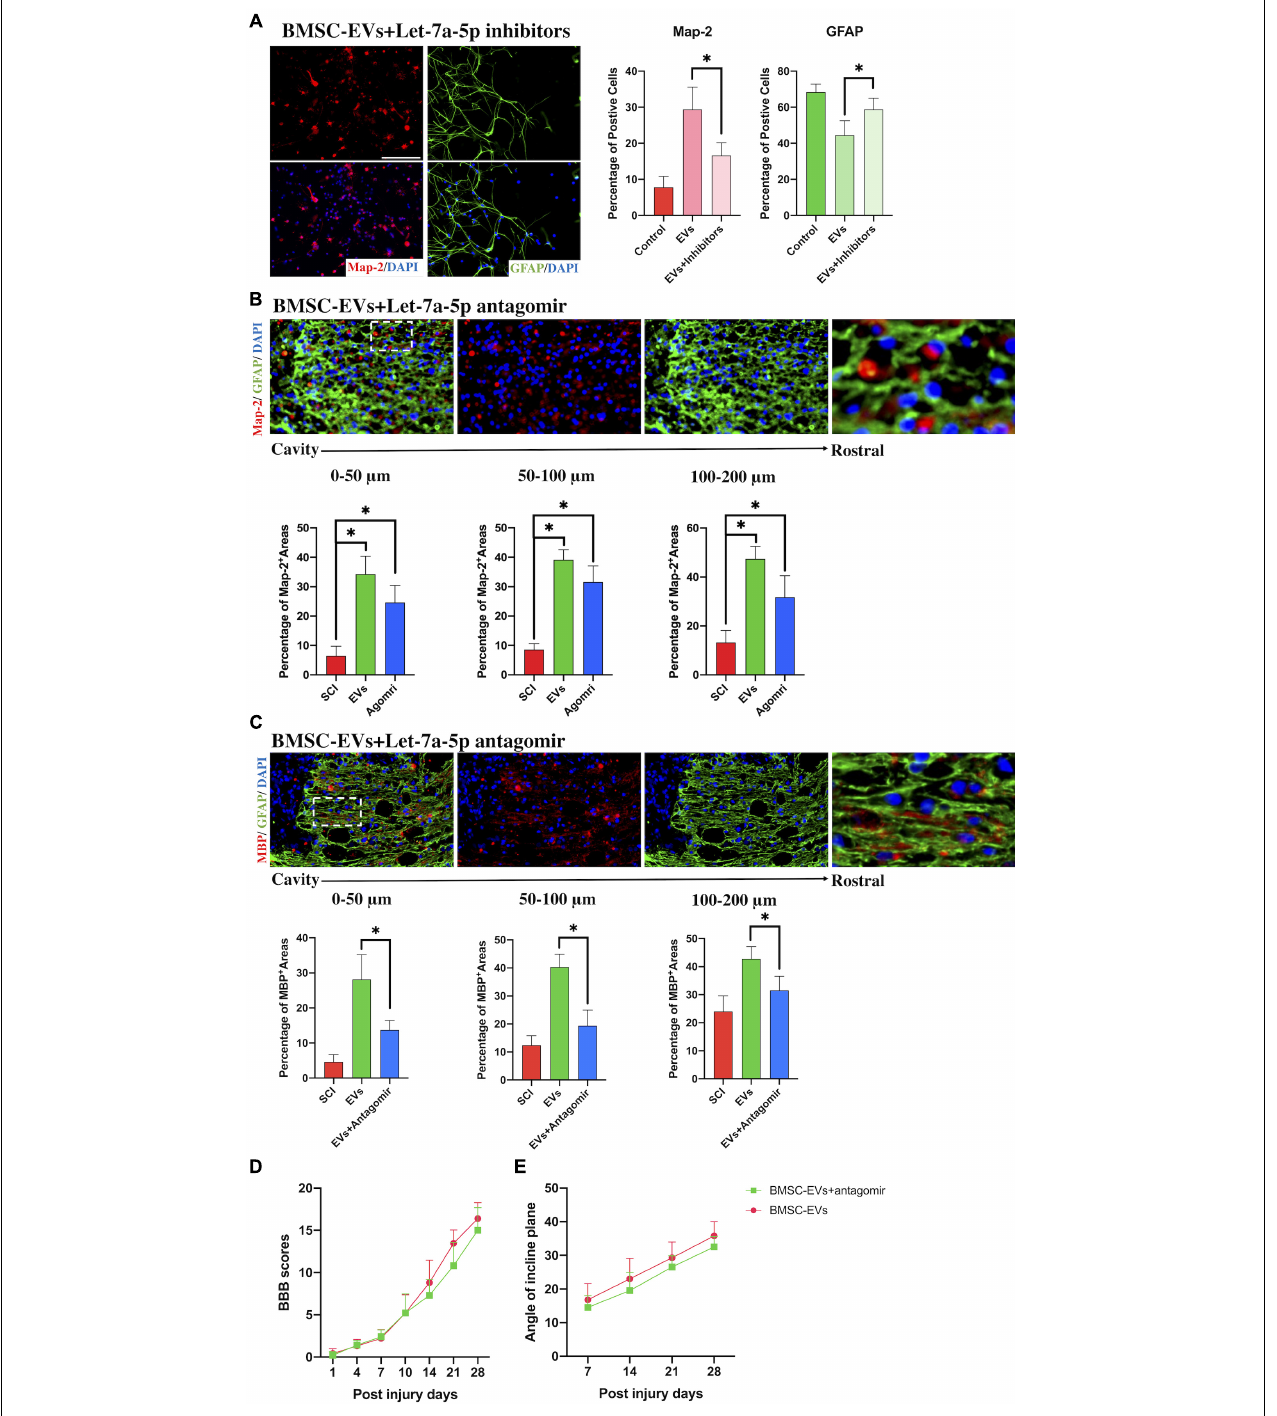
FIGURE 3 | The inhibition of let-7a-5p attenuated the BMSC-EV-induced effects in vitro and in vivo . (A) The transfection of let-7a-5p inhibitors to NSCs in the presence of BMSC-EVs reduced the percentage of neurons and increased the proportion of astrocytes compared with the NSCs that only received the BMSC-EV treatment ( n = 5; data are mean ± S.D; Student’s t- test was used for comparisons. ∗ p < 0.05; scale bar, 100 µ m). (B,C) The addition of let-7a-5p antagomirs reduced the Map-2 and MBP positive areas in glial scars in BMSC-EV-treated SCI rats ( n = 5, data are mean ± S.D; Student’s t- test was used for comparisons. ∗ p < 0.05; scar bar, 50 µ m) and resulted in a worse BBB score (D) and lower max angle of incline plane tests (E) compared with the rats that only received BMSC-EV treatment ( n = 10; data shown as mean ± S.D). The term BMSC-EVs is abbreviated as EVs, let-7a-5p agomir is abbreviated as agomir, and let-7a-5p inhibitors are abbreviated as